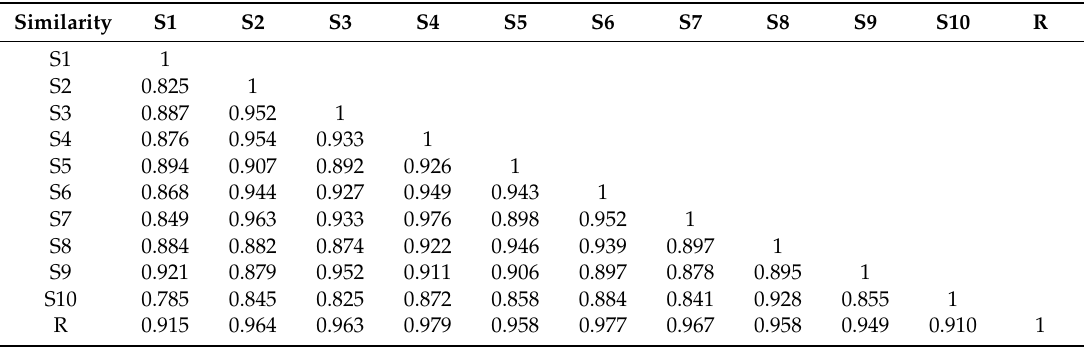
Table 3. Evaluation results of 10 batches of T. patula samples.